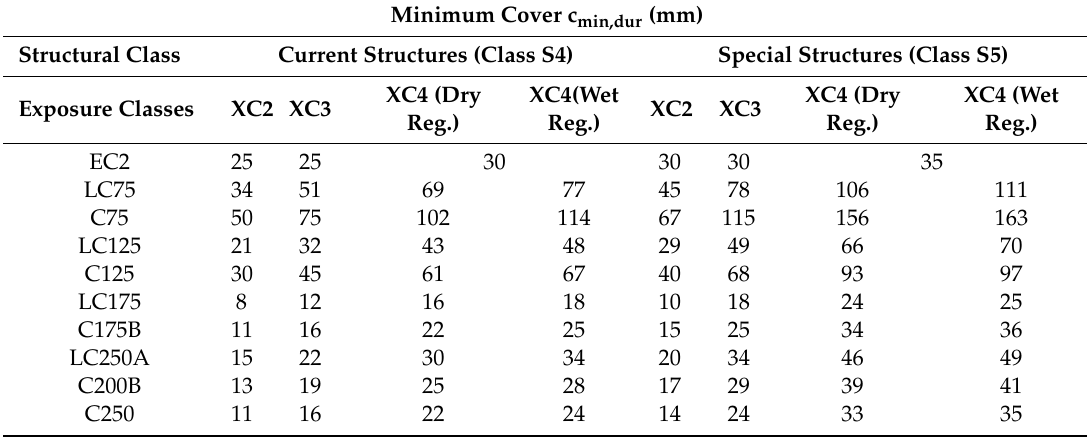
Table 6. Minimum cover according to standards and for the studied concrete regarding